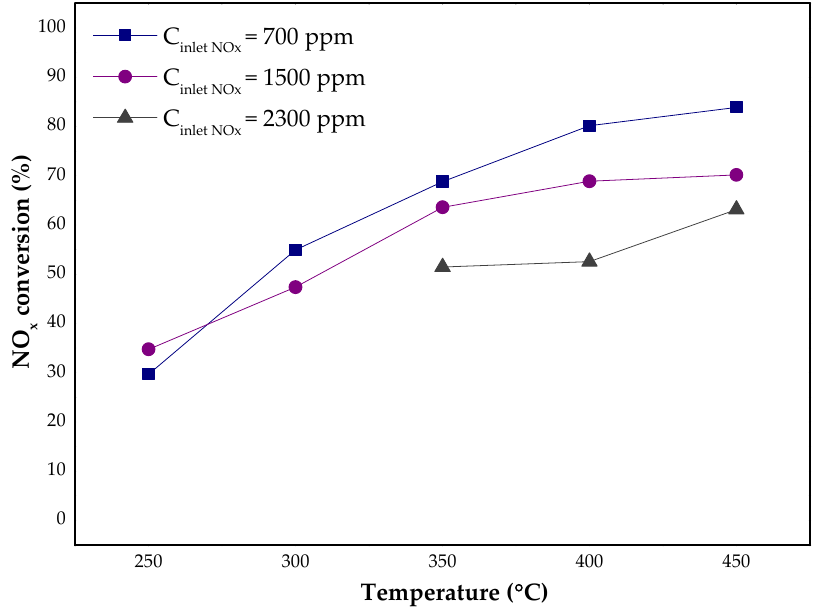
Figure 8. The results of NO x conversion and N 2 O concentration as a function of temperature and NO x inlet concentration for the Fe-Clin-I at GHSV = 26,500 h − 1 , C inlet (NO x ) = 700, 1500, 2300 ppm.